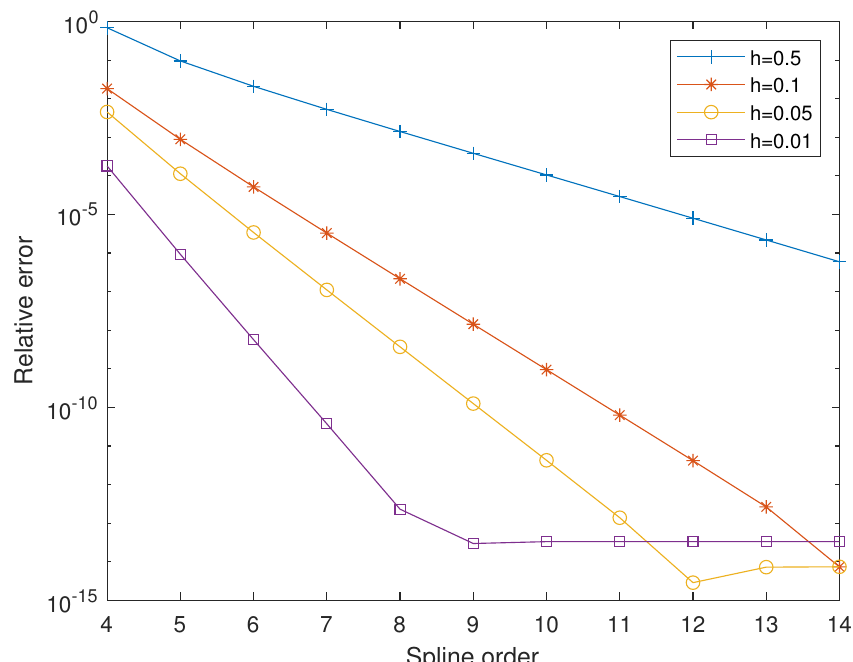
Figure 5. Relative errors, for the nonlinear matrix problem (35), depending on the spline order.